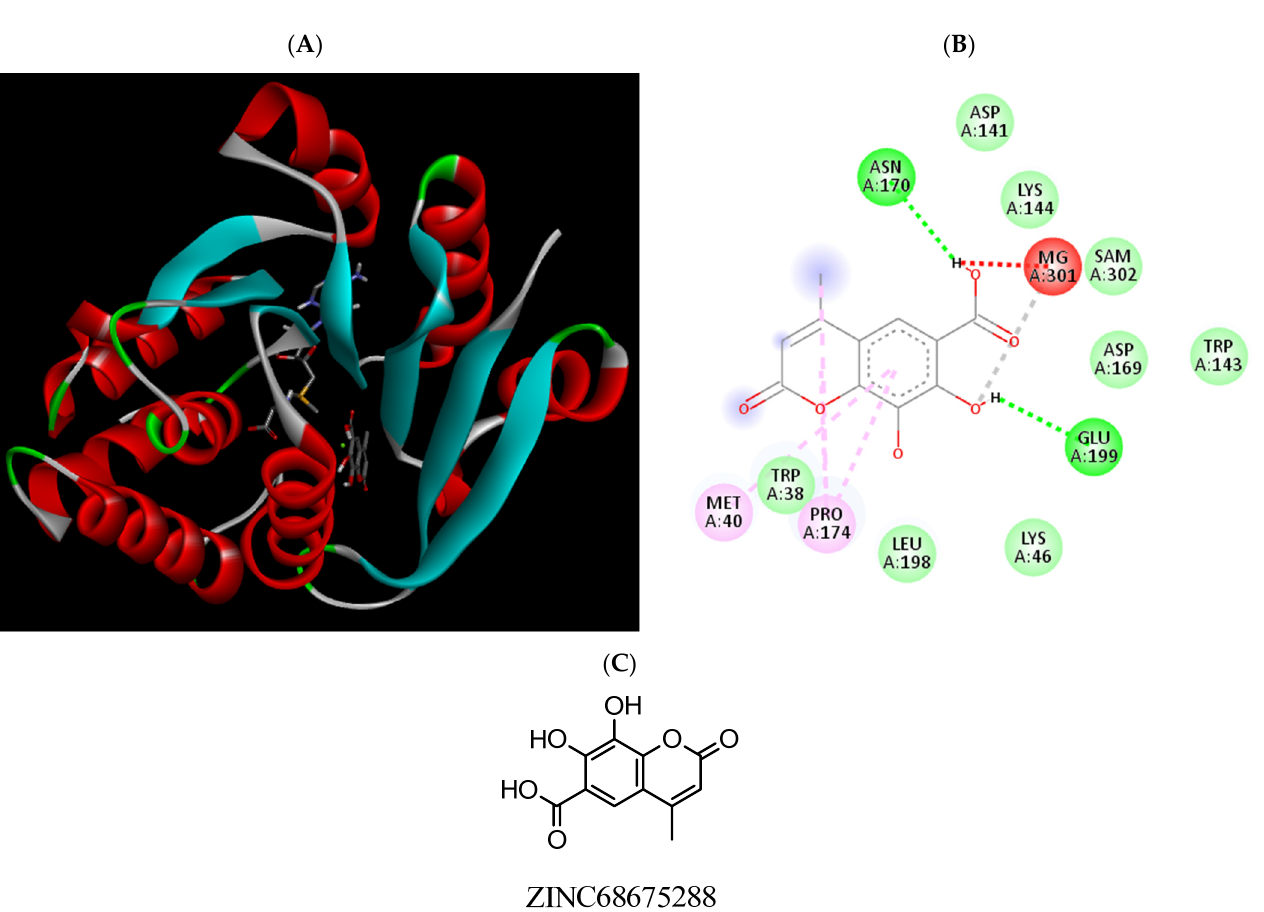
Figure 12. ( A ) Binding modes of ZINC68675288 with the crystal structure of human COMT complexed with SAM and Mg 2+ , ( B ) receptor–ligand interactions, ( C ) 2D representation of ZINC68675288.